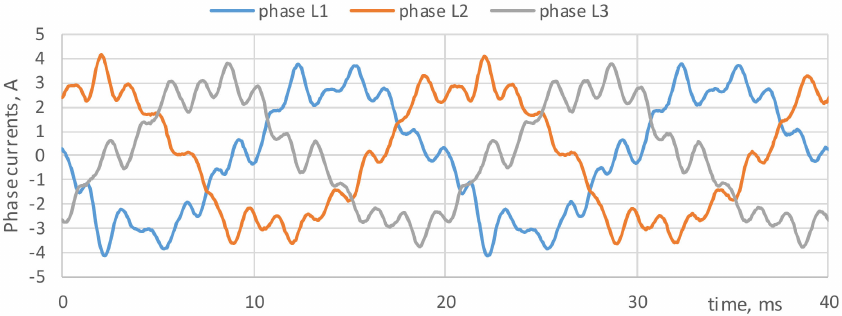
Figure 22. Exemplary MV phase current waveforms for the photovoltaic power station for generated active power equal to 25 kW.